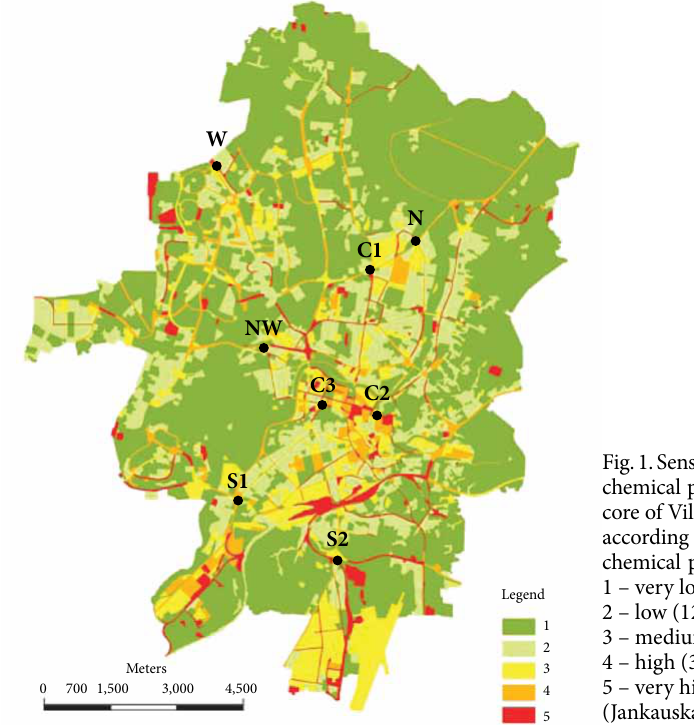
Fig. 1. sensitivity of territorial units to chemical pollution in the urbanized core of Vilnius. legend of categories accor ding to scores of sensitivity to chemical pollution (s): 1 – very low (s ≤ 12.5), 2 – low (12.5 < s ≤ 25), 3 – medium (25 < s ≤